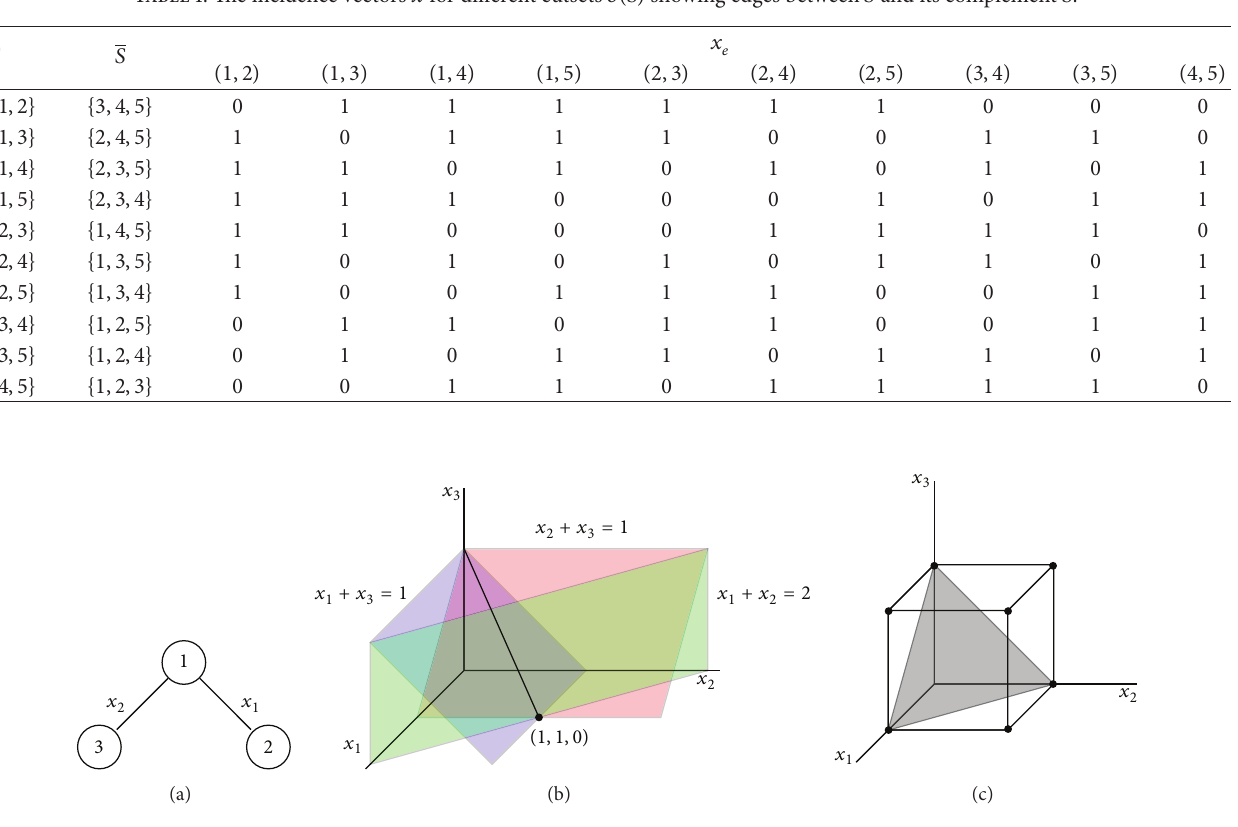
Figure 4: The graph 𝐺 from Example 4 in (a) and the polytope in (b) obtained from the degree constraints, and the polyhedron 𝑄 in (c) from only the cutset including the bound 1 constraints. The degree constraints in (b) show that their intersection at (1,1, 0) is the only possible solution here. The line in (b) indicates where the faces induced by the constraints 𝑥 1 + 𝑥 3 = 1 and 𝑥 2 + 𝑥 3 = 1